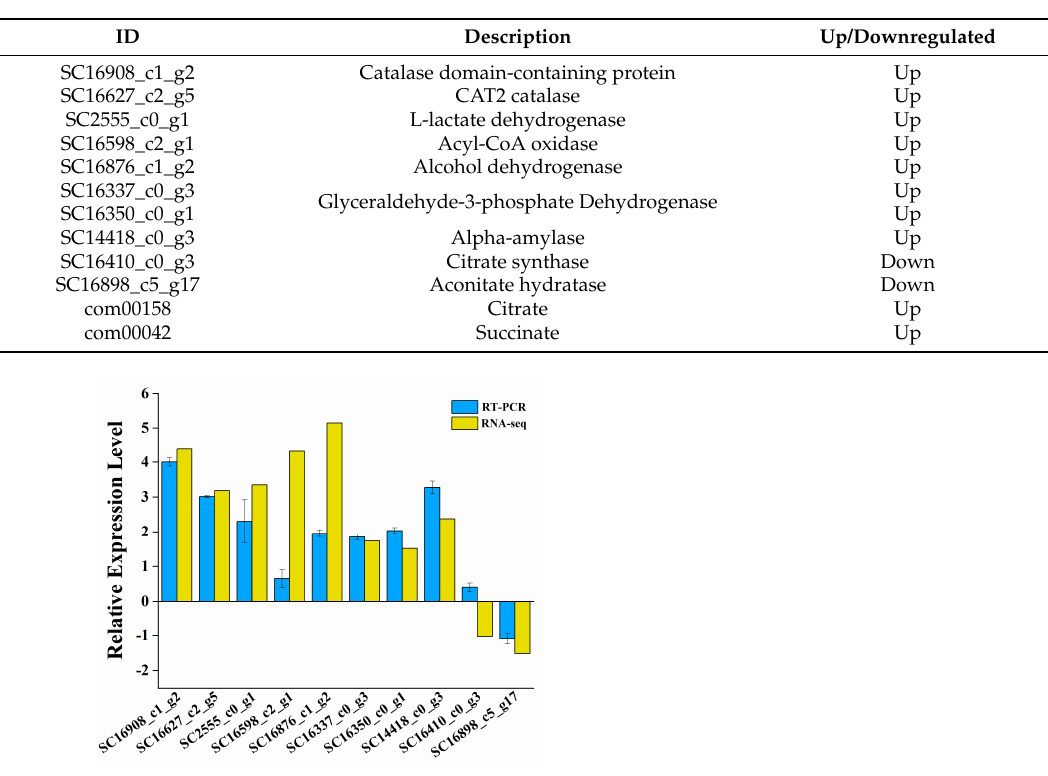
Figure 5. Metabolome analysis of the SCs and YL in Aureobasidium pullulans NG . ( A ) PLS − DA plots between the treated group (SCs) and the control group (YL). ( B ) OPLS − DA plots between the treated group (SCs) and the control group (YL). POS and NEG represent the positive and negative ion modes of mass spectrometry, respectively. ( C ) Hierarchical cluster and heatmap displaying the abundances levels of DAMs in all the samples.